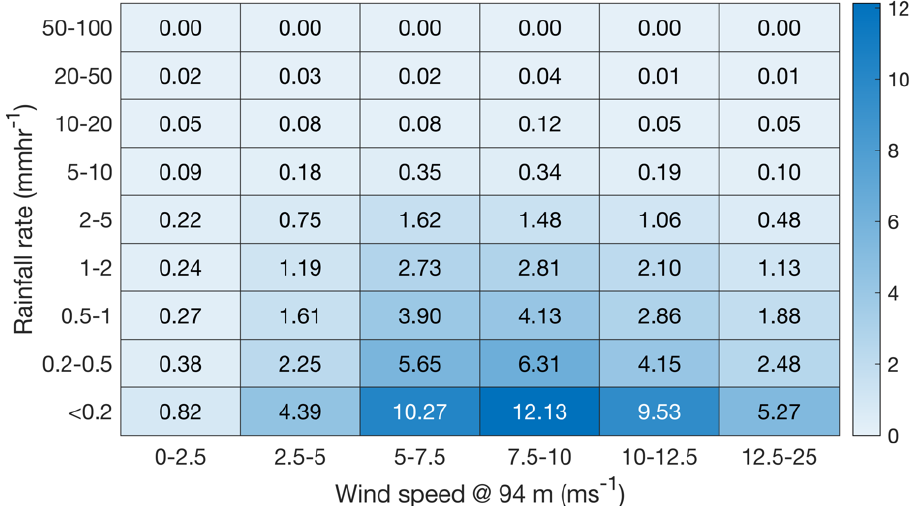
Figure 12. Heatmaps of the joint probabilities (in %, colorbar and also numeric values shown in each cell) of RR and wind speeds at coastal Norway. The probabilities are computed using once hourly wind speeds at a nominal height of 100 m from NORA3.